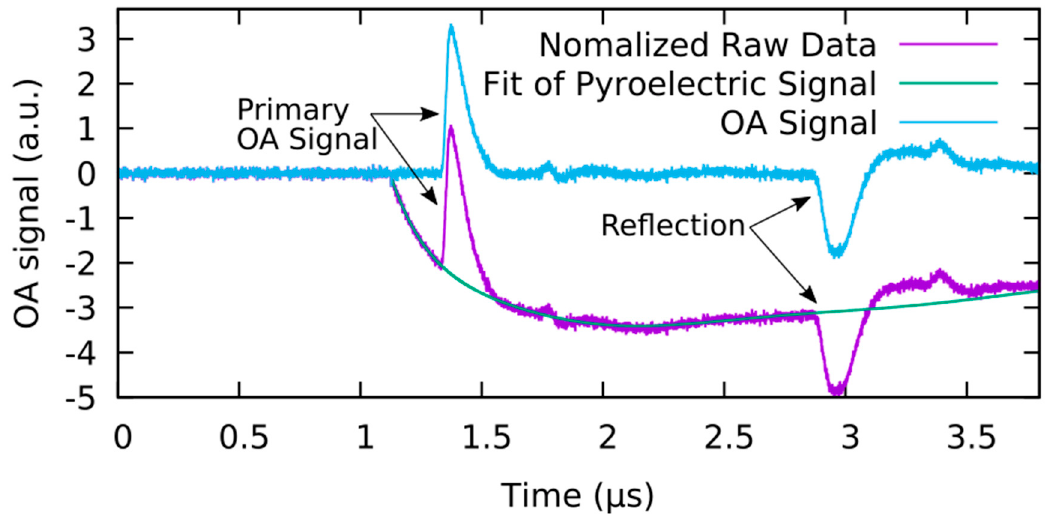
Figure 4. Removal of the pyroelectric signal from the measurement of the instrument response function (IRF). Pyroelectrical signal begins at the time of the laser excitation at 1.12 µs. Primary OA signal arrives at 1.33 µs.